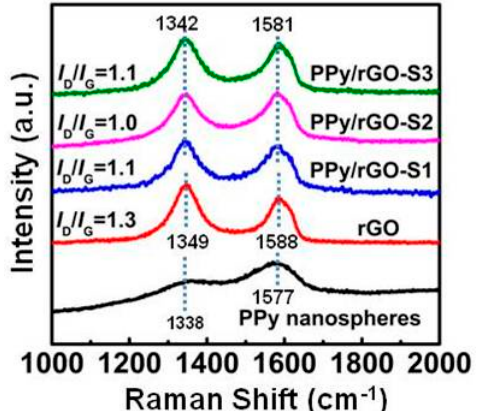
Figure 4. Raman spectra of PPy nanospheres, rGO, and PPy nanosphere/rGO composites.